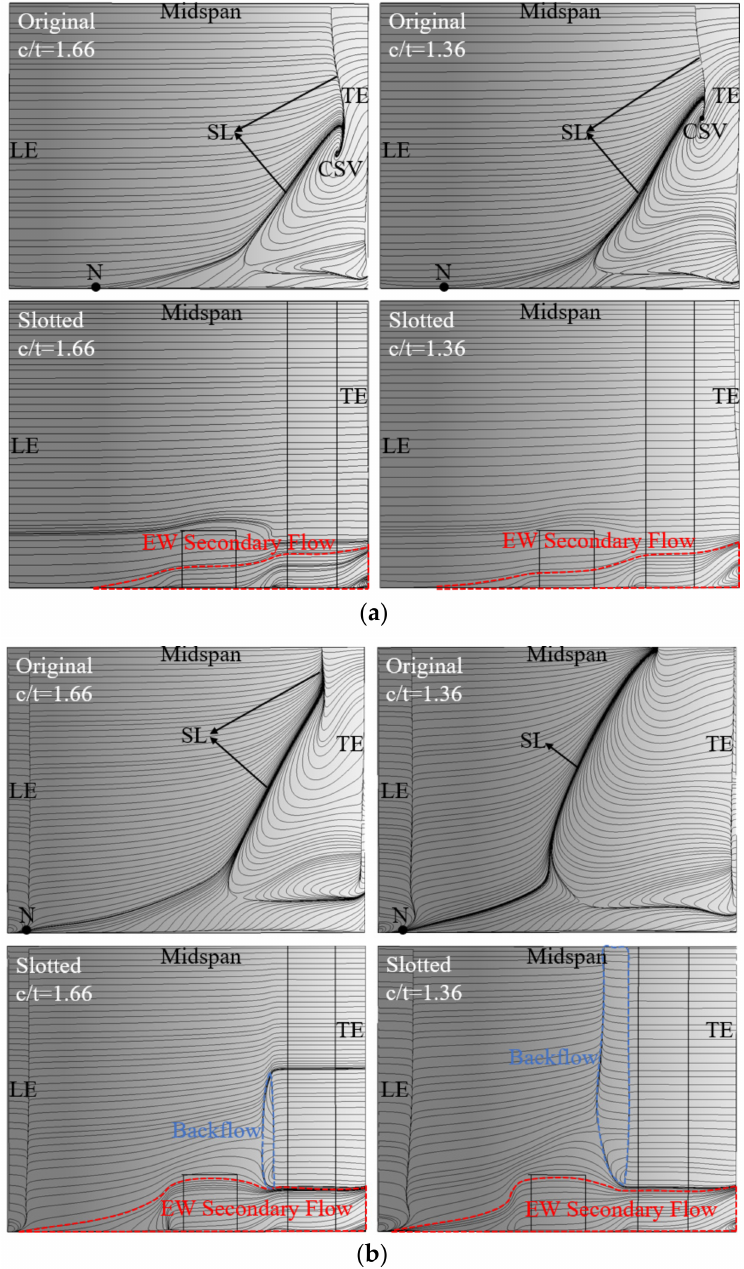
Figure 9. Limiting streamlines on the blade SS of the original cascade and combined slotted cascade: ( a ) 0 ◦ ; ( b ) 6 ◦